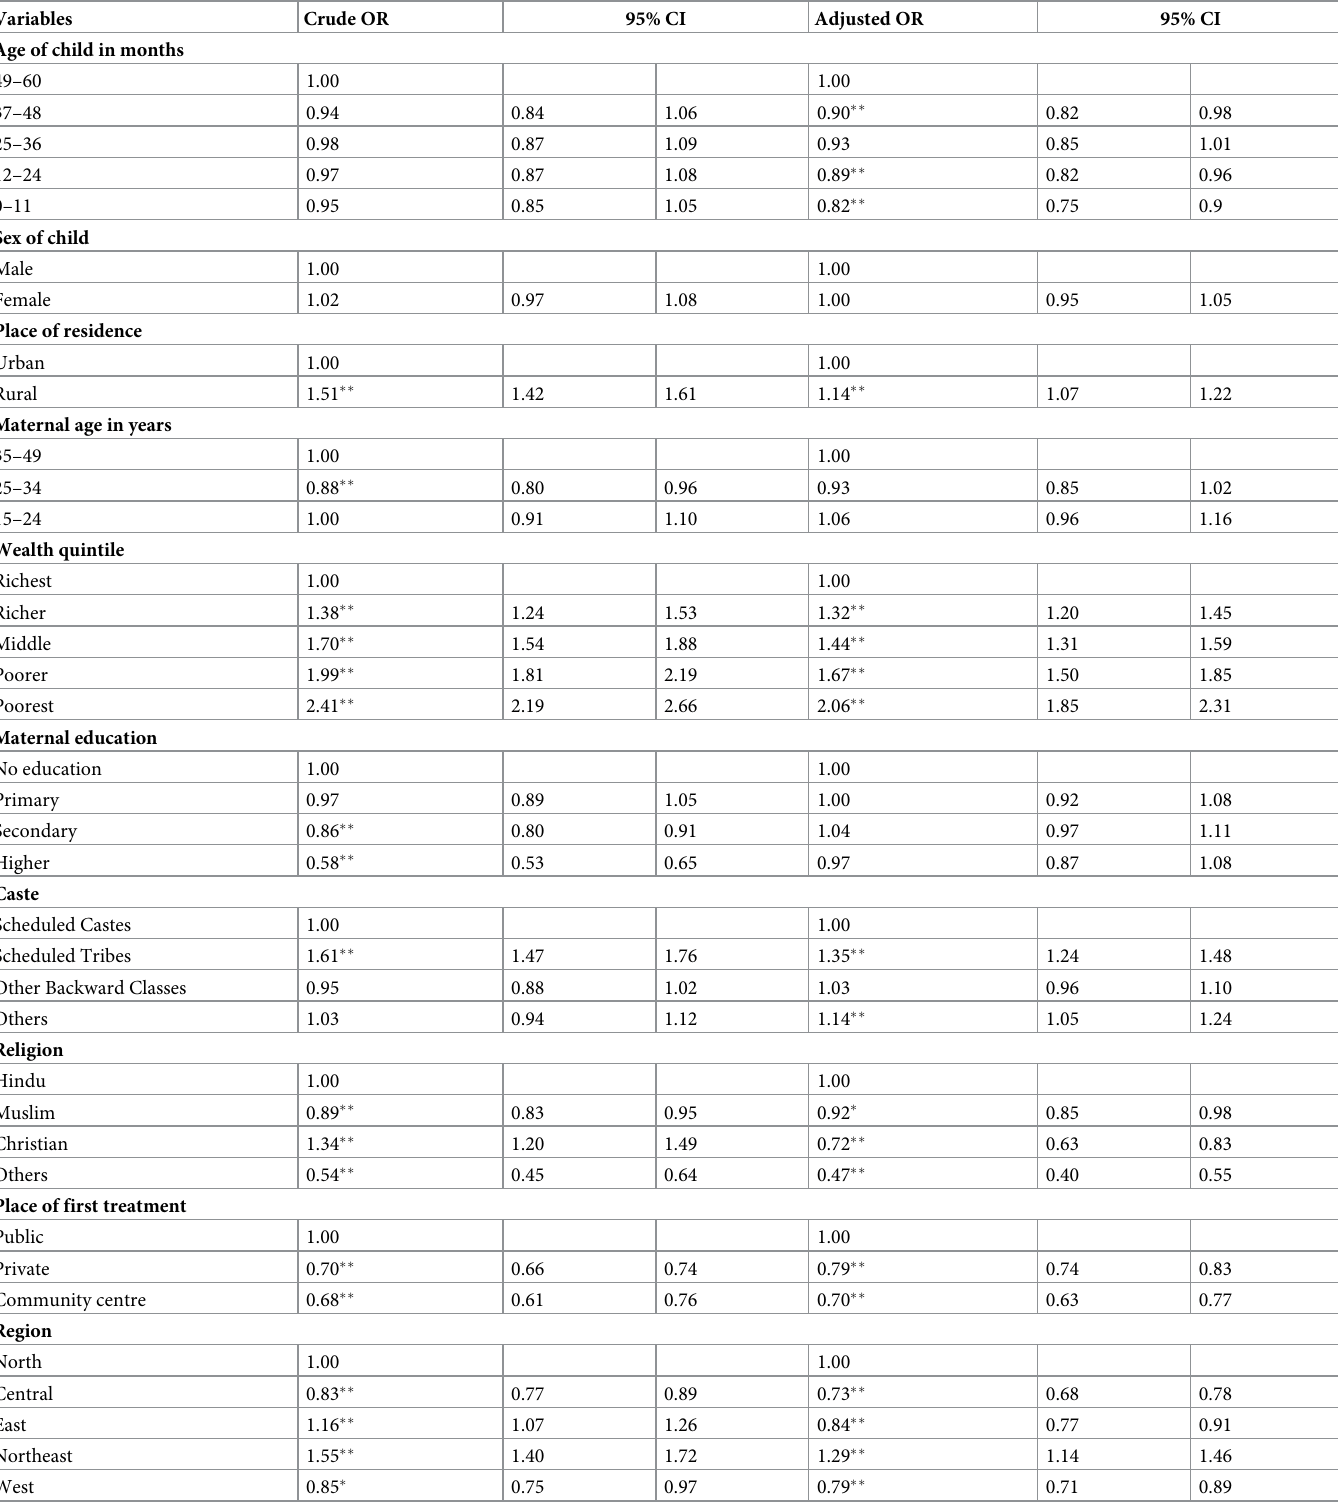
Table 2. Factors associated with delay in treatment-seeking behaviour of caregivers of under-five children with fever in India NFHS-4, (2015–16).